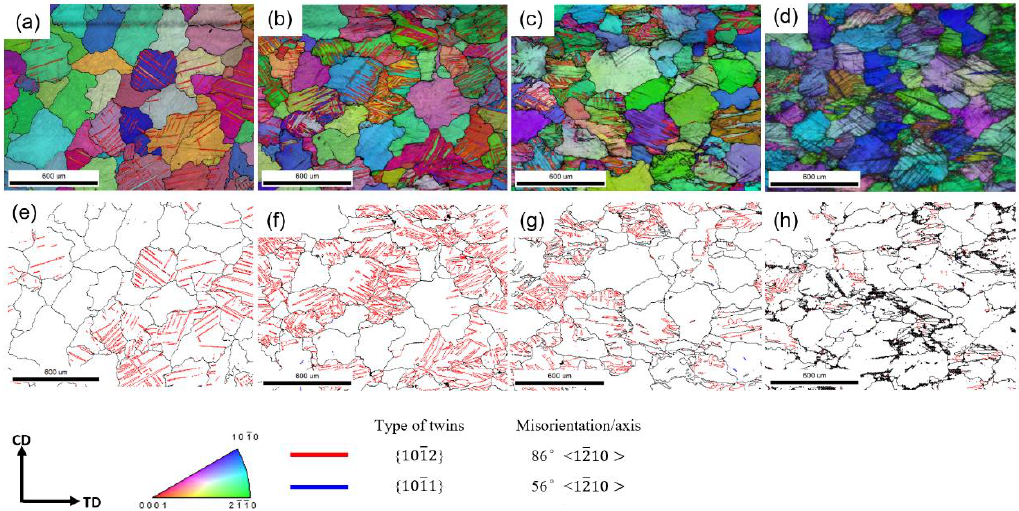
Figure 9. The IPF + IQ + GB map of the specimens at ( a ) P2, ( b ) P3, ( c ) P4, ( d ) P5, and the correspond- ing GB map of specimens at ( e ) P2, ( f ) P3, ( g ) P4, ( h ) P5.